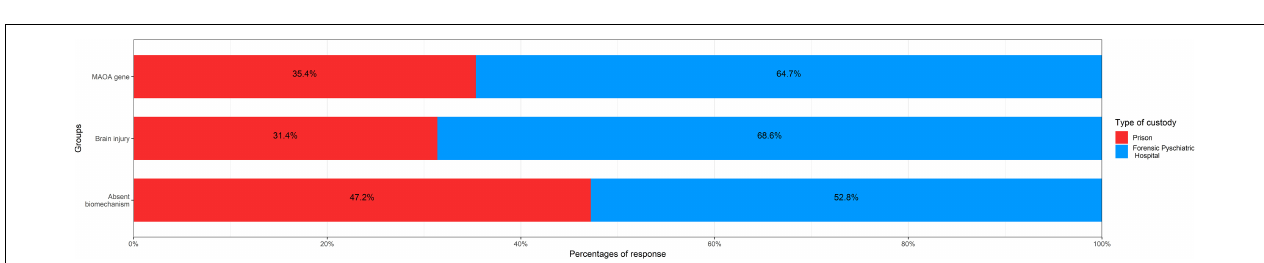
FIGURE 5 | Plot of proportional cross-tables (contingency tables) showing the response to the question, which type of custody should be assigned to the offender depending on the group of respondents.